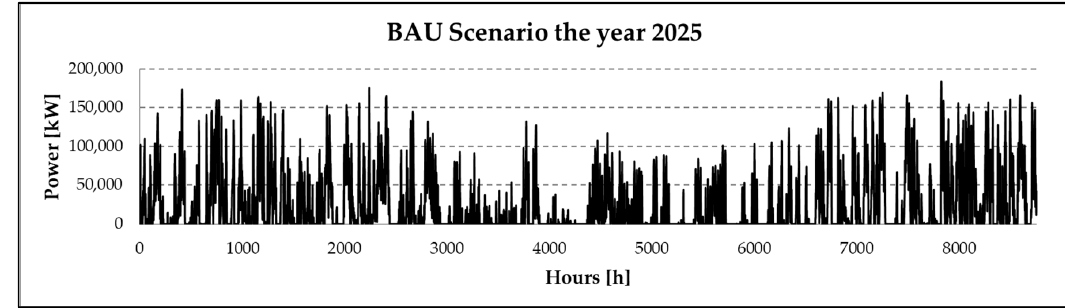
Figure 3. Rejected wind power time series for Business as Usual energy planning scenario under examination forecasted for the year 2025.